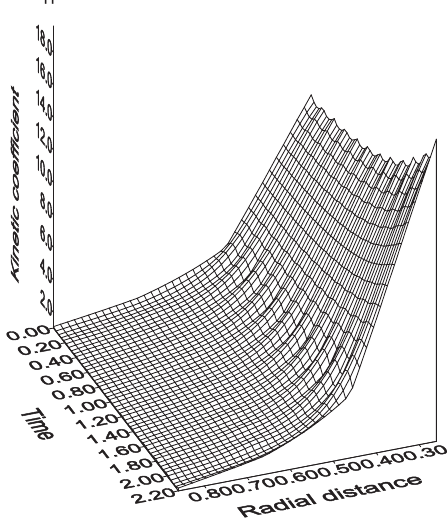
Figure 4.10 . Variation of the kinetic coe ffi cient L tance and